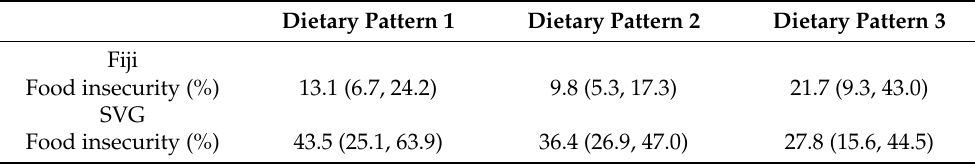
Table 6. Food insecurity by dietary patterns in Fiji and SVG. Figures are percentages (95%